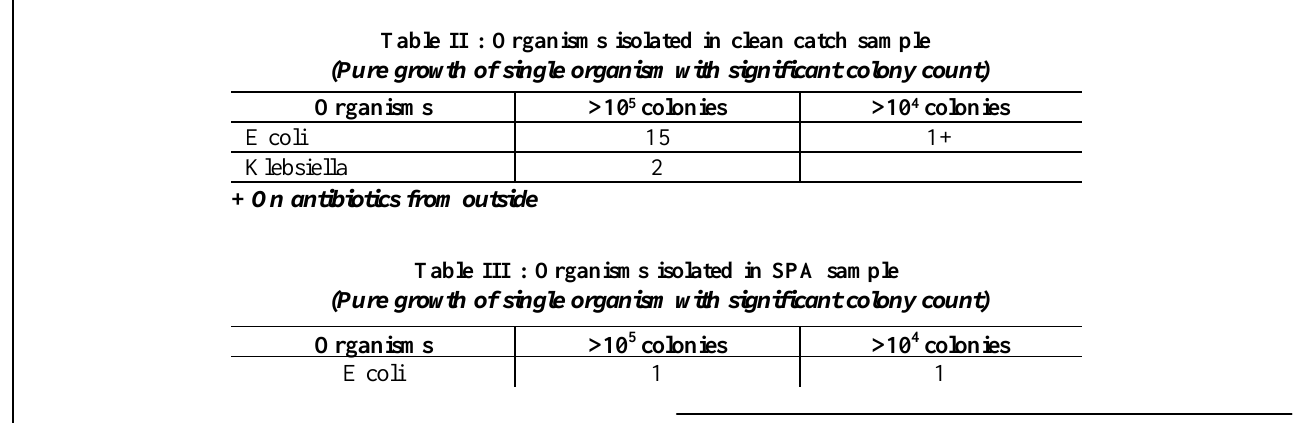
Table II : Organisms isolated in clean catch sample